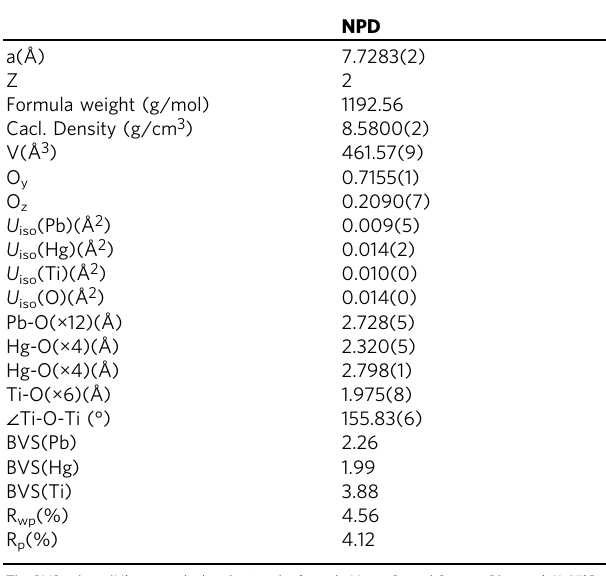
The BVS values ( V i ) were calculated using the formula V i = Σ j S ij , and S ij = exp[( r 0 − r ij )/0.37)]. In PHTO, r 0 = 2.112 for Pb, 1.972 for Hg and 1.815 for Ti. For the A-site Pb, 12-coordinated oxygen atomswere used. For the A ′ -site Hg, 8-coordinated oxygen atoms were used. For the B- site Ti, 6-coordinated oxygen atoms were used. b Space group: Im -3; Atomic sites: Pb 2 a (0, 0,